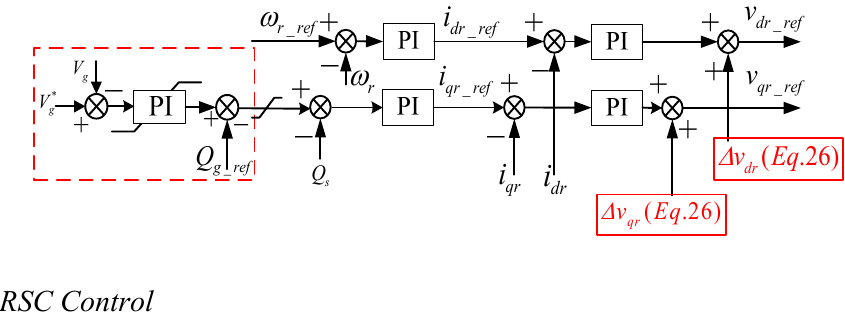
Figure 10. Enhanced control of the